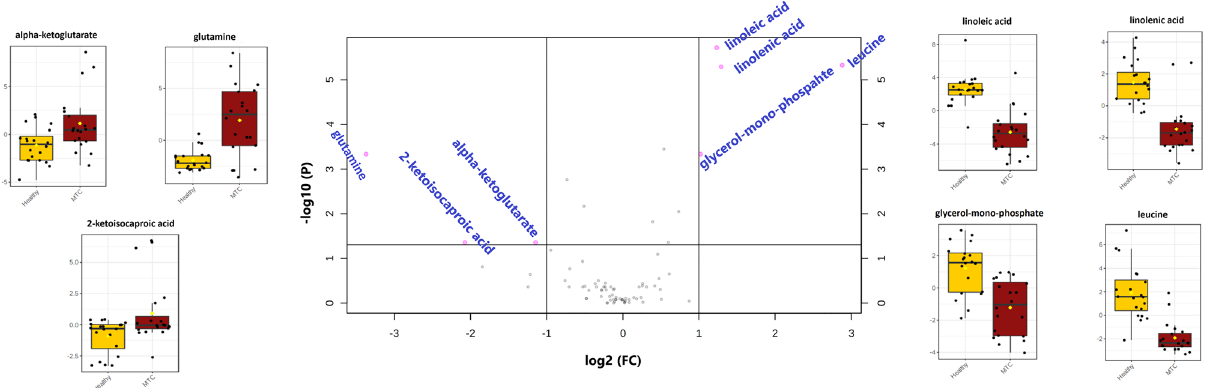
Figure 2. Volcano plot analysis of the most significant metabolite changes comparing MTC versus Healthy. Pink dots on the left indicate metabolites in plasma samples of MTC patients have significantly higher intensity in compression with the healthy group; meanwhile, the pink dots on the right indicate metabolites here are significantly lower in plasma samples of MTC patients compared to healthy subjects. Gray dots refer to all the other identified metabolites with no significant changes between MTC patients and the healthy group. Box and Whisker plots show the normalized values of seven selected metabolites by volcano plot. The x -axis shows the specific metabolite, and the y -axis is the normalized peak intensity.